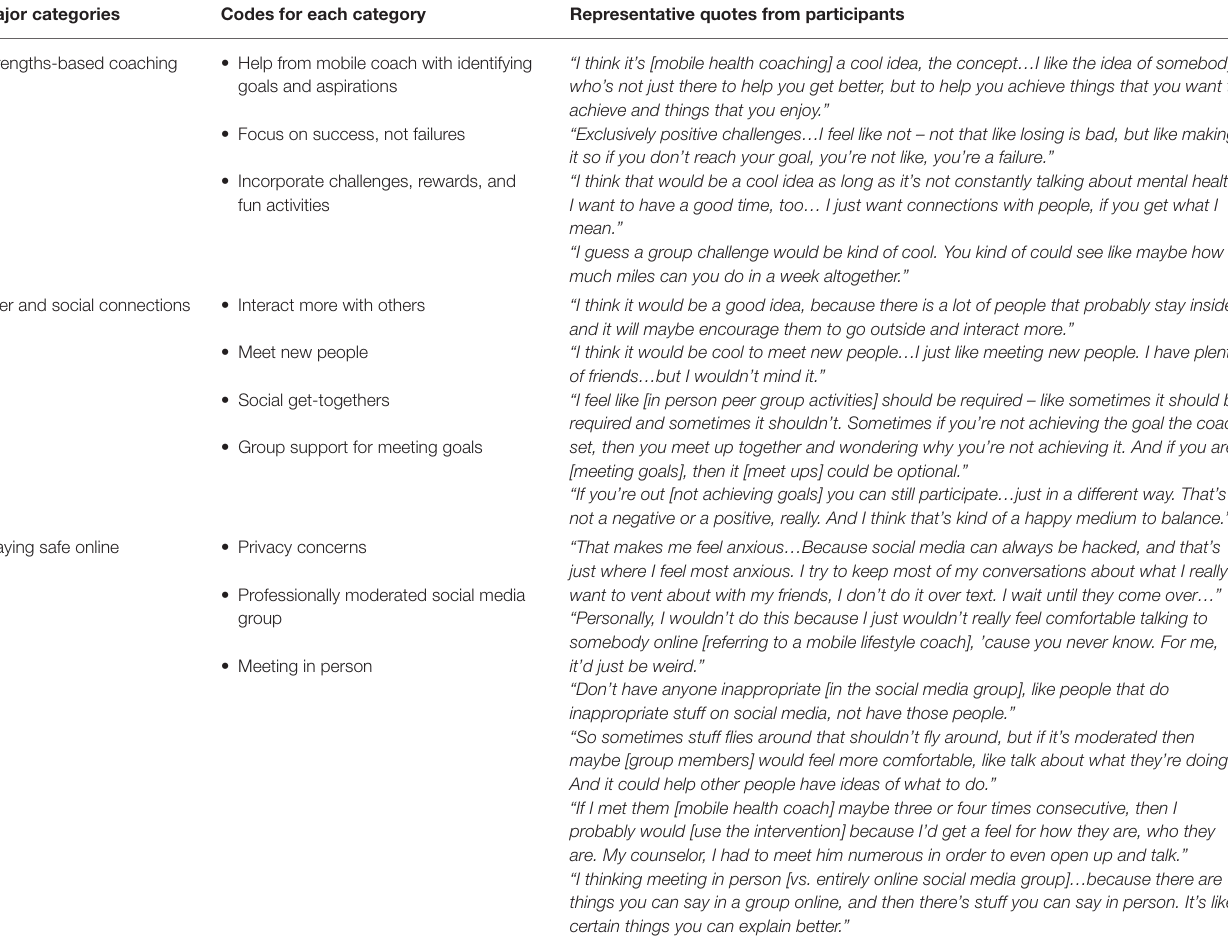
TABLE 2 | Thematic categories derived from adolescents’ input on intervention development. Major